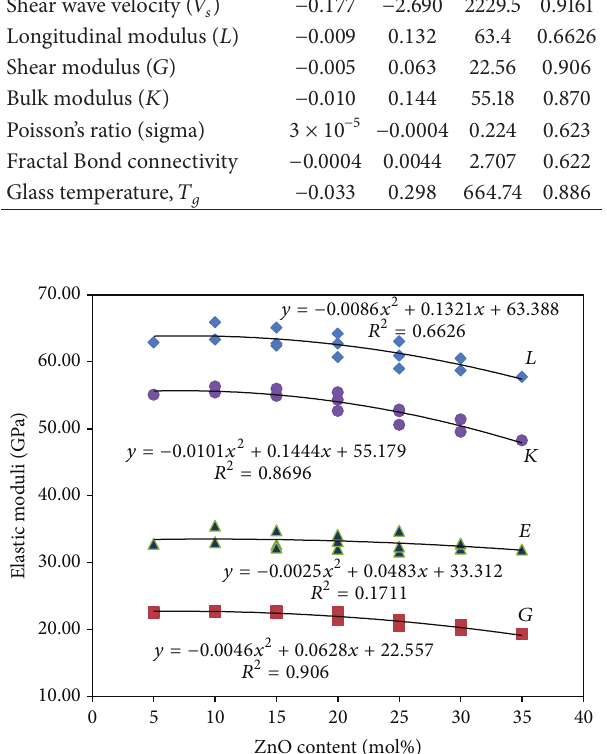
Figure 3: Variation of elastic moduli (i.e., longitudinal modulus ( 𝐿 ), shear modulus ( 𝐺 ), bulk modulus ( 𝐾 ), and Young’s modulus ( 𝐸 ) for ZOFT glass series).